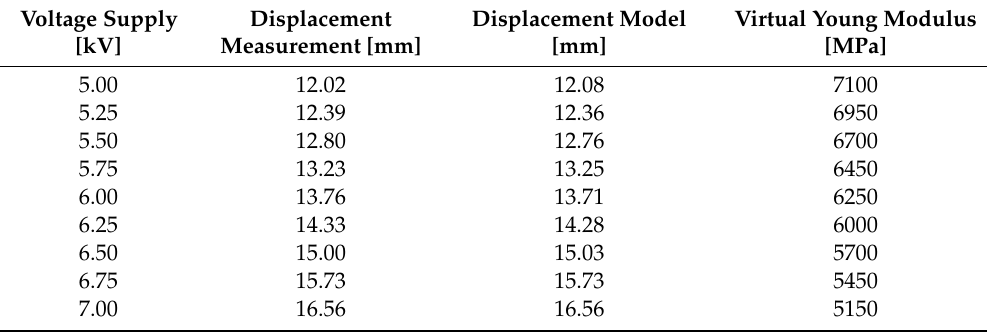
Table 4. The comparison of the displacements for di ff erent voltage supply and load force 1.03 [N].